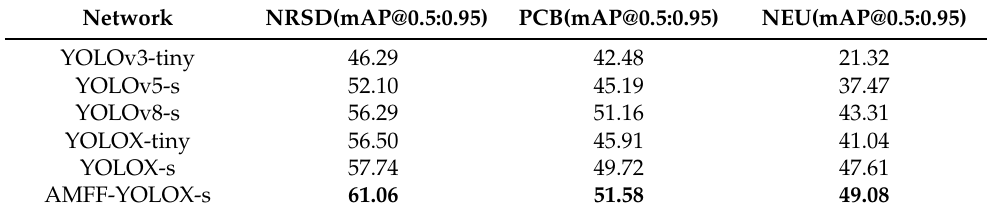
Table 2. Comparative experimental results (mAP@0.5:0.95) of detection in the industrial defect dataset. Network